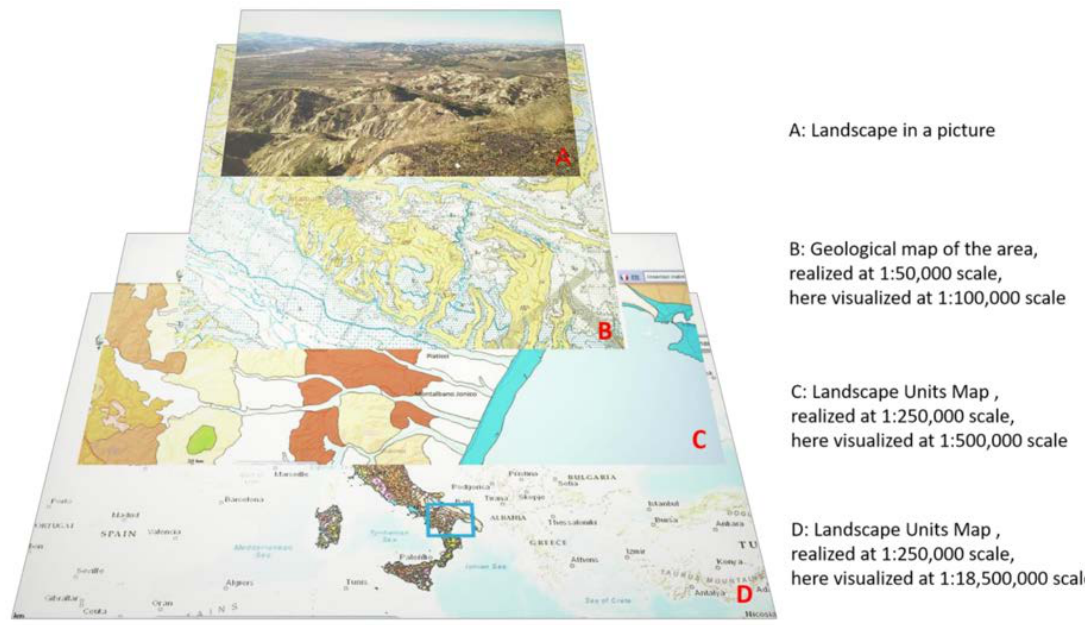
Figure 2. A schematic representation of the multiscale approach in the case